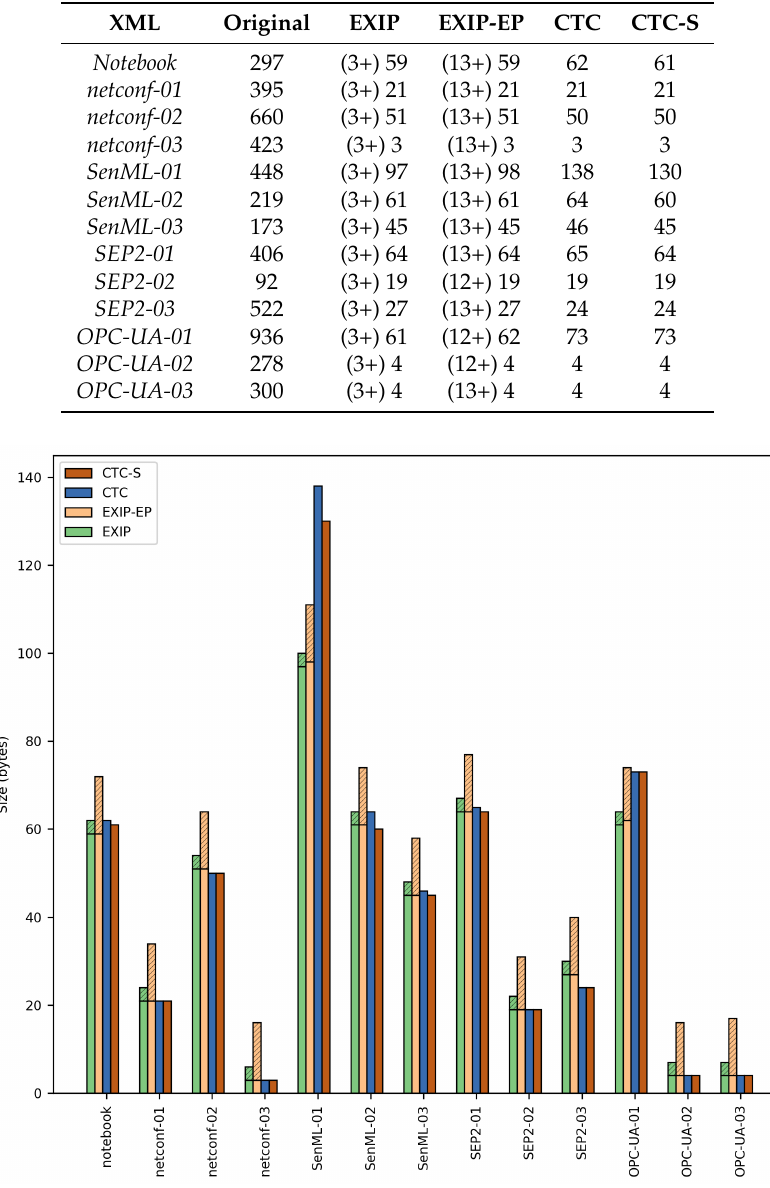
Figure 10. XML document compression comparative in bytes. EXIP : schema strict mode, all preserve options to F ALSE and schemaId to constant string “1”. EXIP-EP : same options as EXIP case plus EXI Profile. CTC : CTC normal compression mode. CTC-S : CTC strict mode. Stacked columns indicate the extra overhead due to EXI options embedded in the EXI